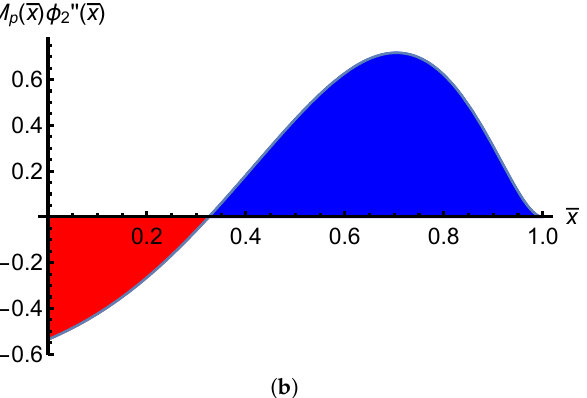
( ¯ x ) . The second mode excitation Figure 5. ( a ) function f 2 ( ¯ x ) , ( b ) graph of the integrand M p ( ¯ x ) φ (cid:48)(cid:48) 2 and c = 5 were considered. The O.V.D. provided one voltage sign change, since f 2 ( ¯ x ) included a minimum at ¯ x = 0.315, while the maximum was at ¯ x = 1. The same result could be obtained by ( ¯ x ) . In this case, the area of this function was negative observing the area subtended by M p ( ¯ x ) φ (cid:48)(cid:48) 2 (highlighted in red colour) within 0 ≤ ¯ x ≤ 0.315, so by changing the voltage sign at ¯ x = 0.315 it was possible to enhance the system’s efficiency because the two areas would be on the same side of the graph.